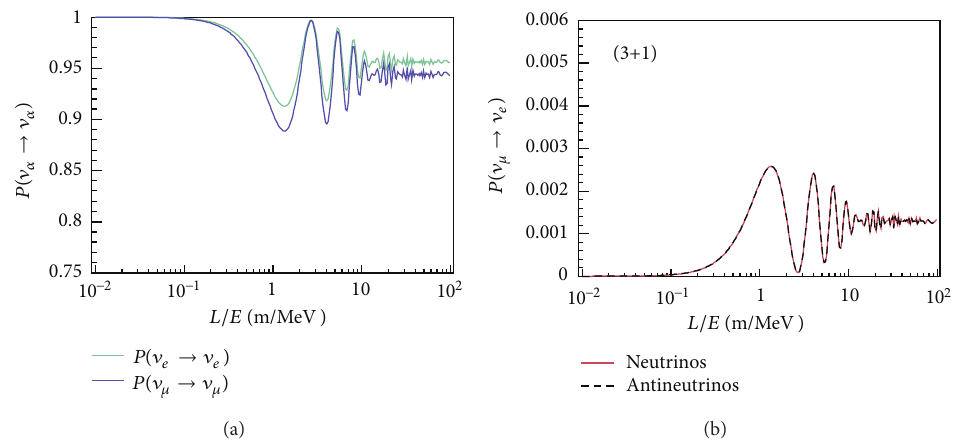
Figure 14: The ( 3 + 1 ) oscillation probabilities for the global best-fit (“all” datasets) values in Table 3 with 10% resolution in 𝐿/𝐸 .